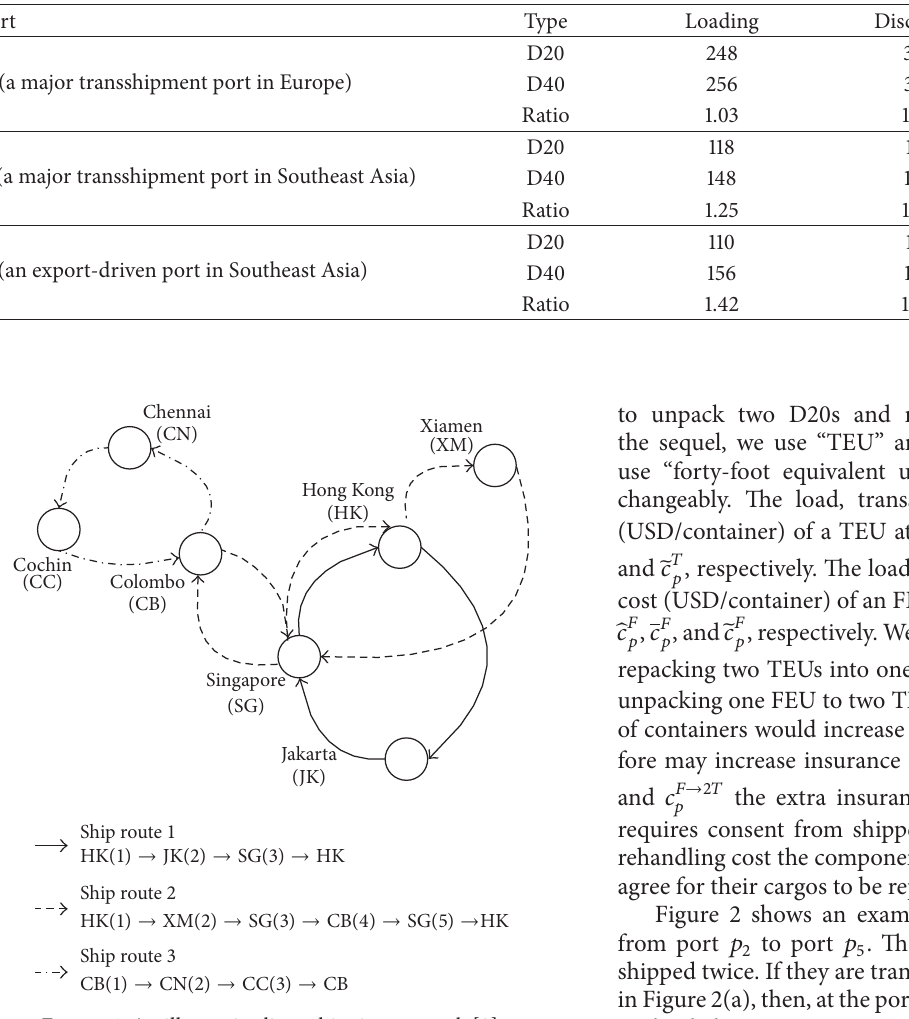
Figure 1: An illustrative liner shipping network